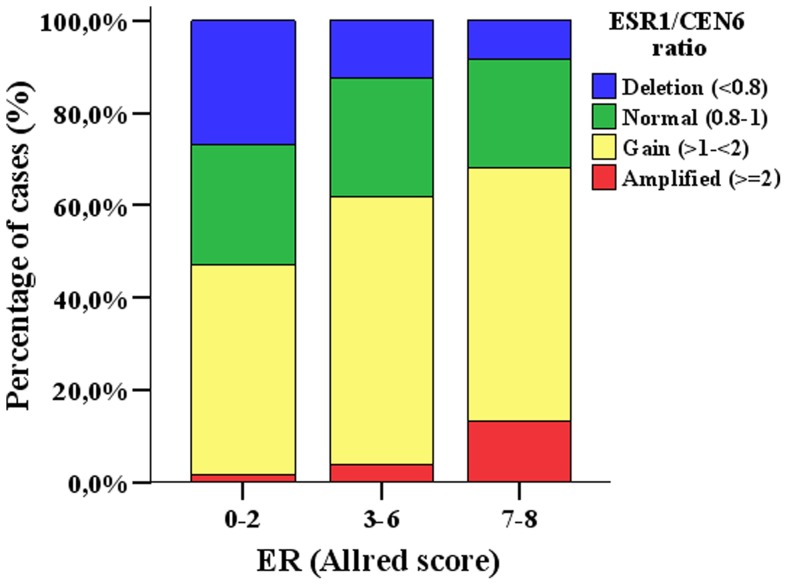
Bar chart of ER IHC protein expression by ESR1/CEP6 gene ratio.